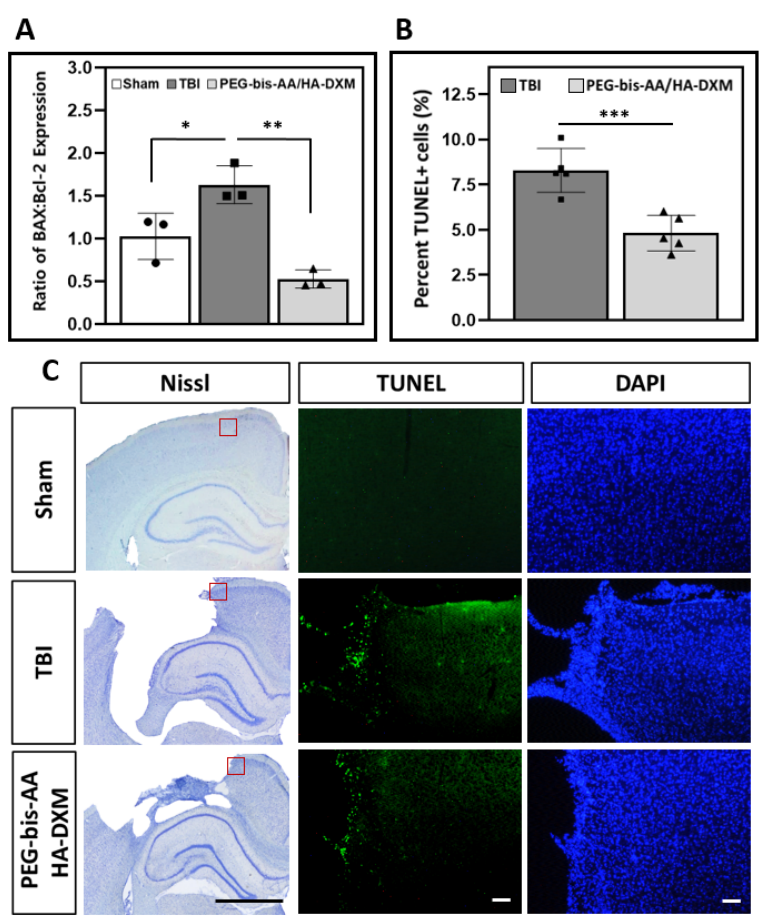
Figure 5. The effect of PEG-bis-AA/HA-DXM treatment on the apoptotic response at 14 DPI. ( A ) The ratio of the relative mRNA expression of BAX to Bcl -2 by RT-PCR ( n = 3 rats/group). ( B ) The average percentage of TUNEL + apoptotic nuclei ( n = 15 sections/group, n = 3 sections/rat, n = 5 rats/group). Data are presented as mean ± STD. * p < 0.05, ** p < 0.01, *** p < 0.001 compared with TBI. ( C ) Representative images of TUNEL + apoptotic nuclei in the ipsilateral cortex. Images are captured in the region indicated by the red box in the Nissl -stained brain sections (black scale bar represents 2 mm). White scale bars represent 100 µm.